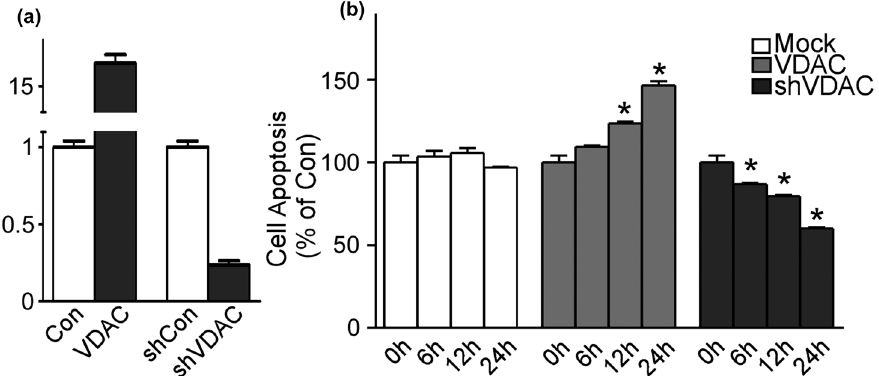
Figure 1: VDAC1 induced cell apoptosis in refractory epilepsy. ( a ) The expression of VDAC1 validated by PCR at upregulation and downregulation. ( b ) Cell apoptosis at di ff erent time points detected by the TUNEL assay. Values represent means ± SD, n = 3. P < 0.05 by Student ’ s t - test.